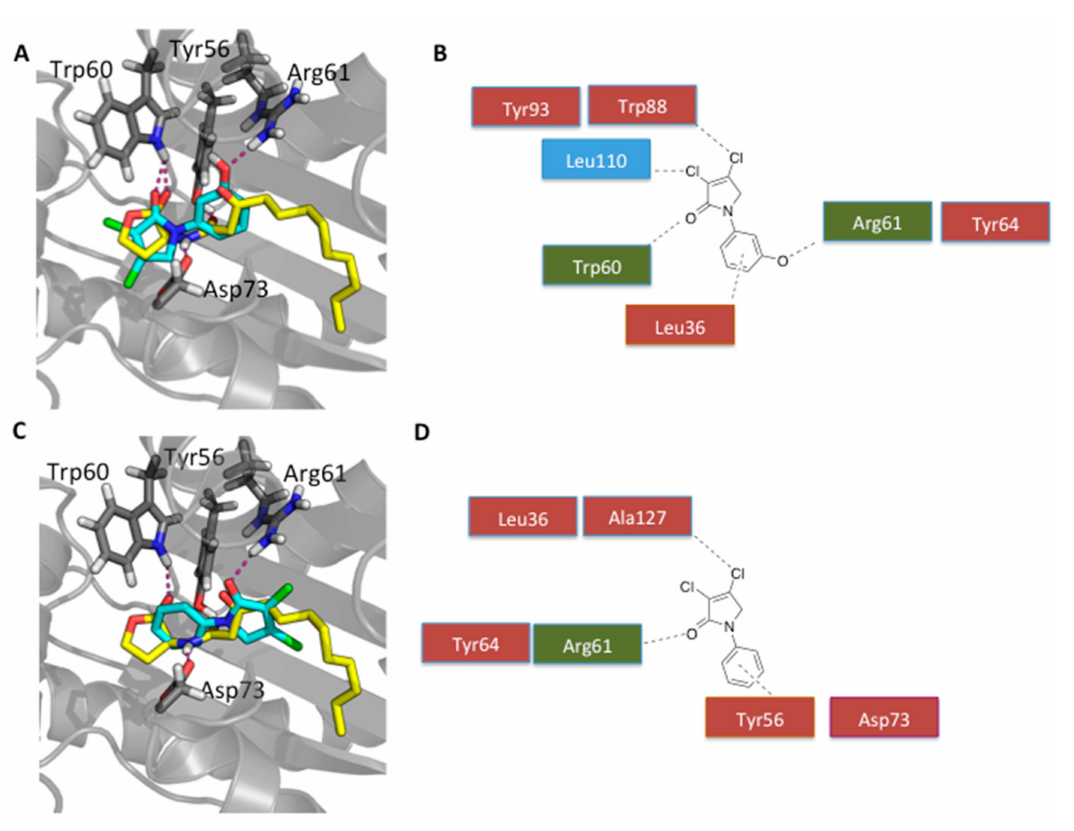
Figure 3. Predicted interactions for ligands 13 and 23 in the binding pocket of LasR compared to N -(3-oxododecanoyl)- L -homoserine lactone 3 (OdDHL) ( 3 ). ( A ) Compound 13 shows OdDHL-like interactions and orientation. Hydrogen bonds are in pink. OdDHL is in yellow. ( C ) Compound 23 shows a flipped orientation relative to the lactone ring of OdDHL. ( B , D ) describe the interactions of 13 and 23 with LasR. Hydrogen bonds are green. Halogen interactions are blue. Hydrophobic and electrostatic interactions are